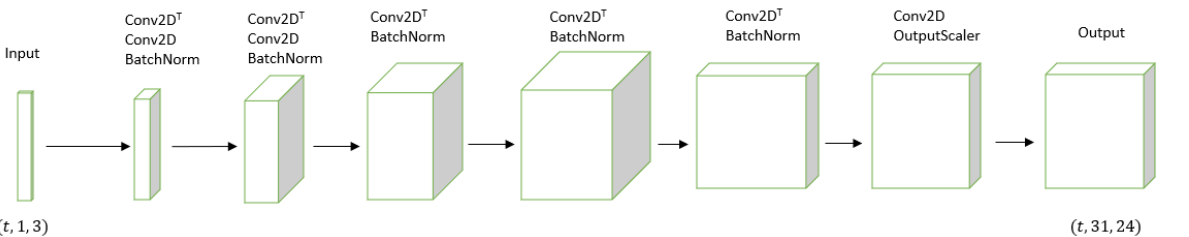
Figure 3. M-SRPCNN Architecture